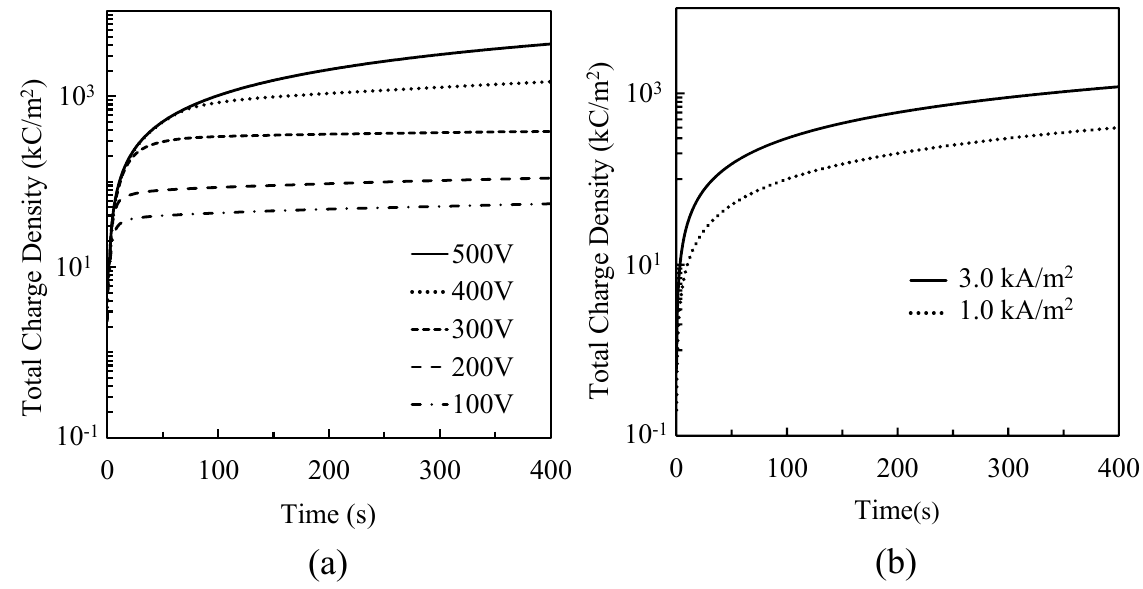
Figure 12. Time variation of the total charge density during the PEO process by ( a ) CV operation and ( b ) CC operation.